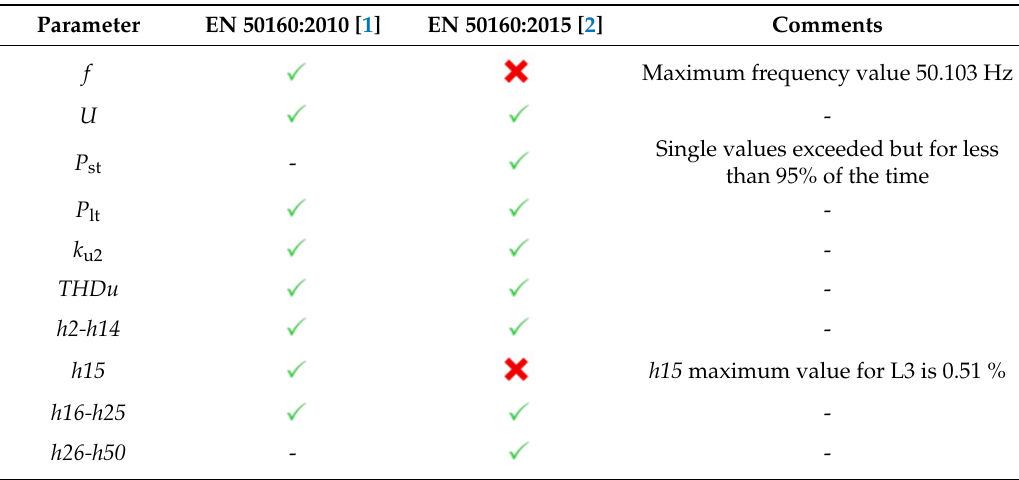
Table 2 Comparison of general results of the power quality assessment obtained using 50160:2010 [1] and 50160:2015 [2].